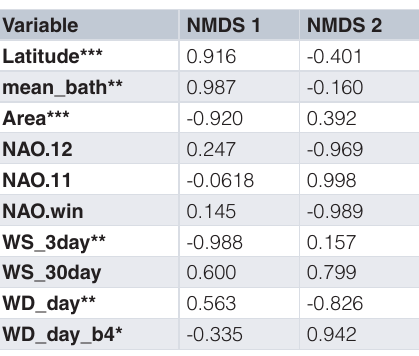
NMDS axes. Sections 1 and 6 are concentrated on the left side of the NMDS axis 1, while sections 2 and 3 are predominantly on the right side. Sections 4 and 5 are located approximately in the middle, as they are in actual Bay